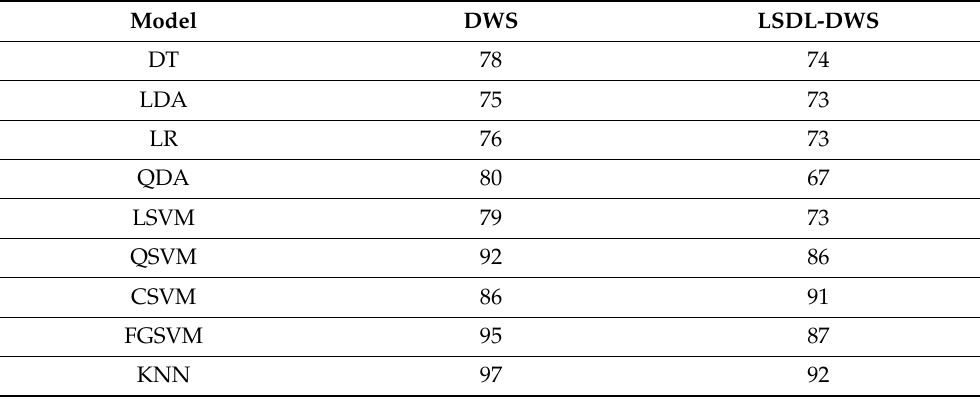
Table 1. Results of the EHG signals.